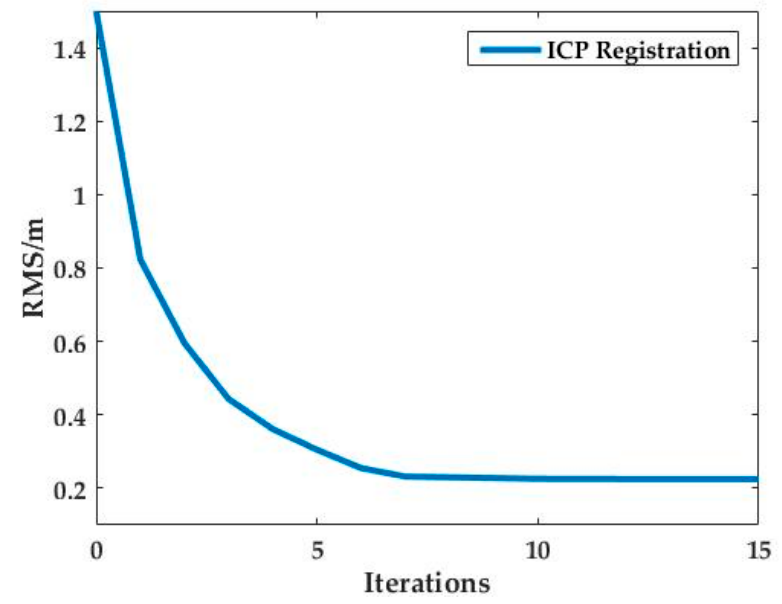
Figure 6. Residual variation in the ICP computation process.